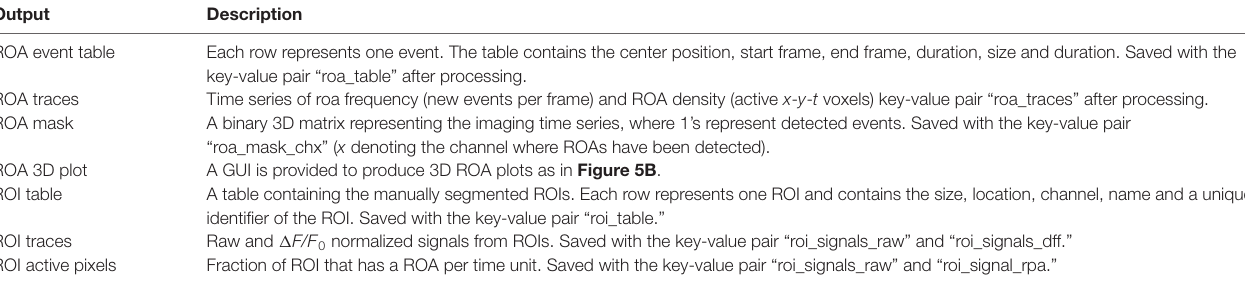
TABLE 1 | The primary outputs from Begonia and where to find